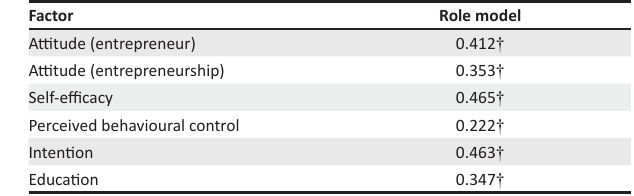
TABLE 10: The Spearman correlations between education and the dimensions of entrepreneurial intentions ( N = 269). Factor